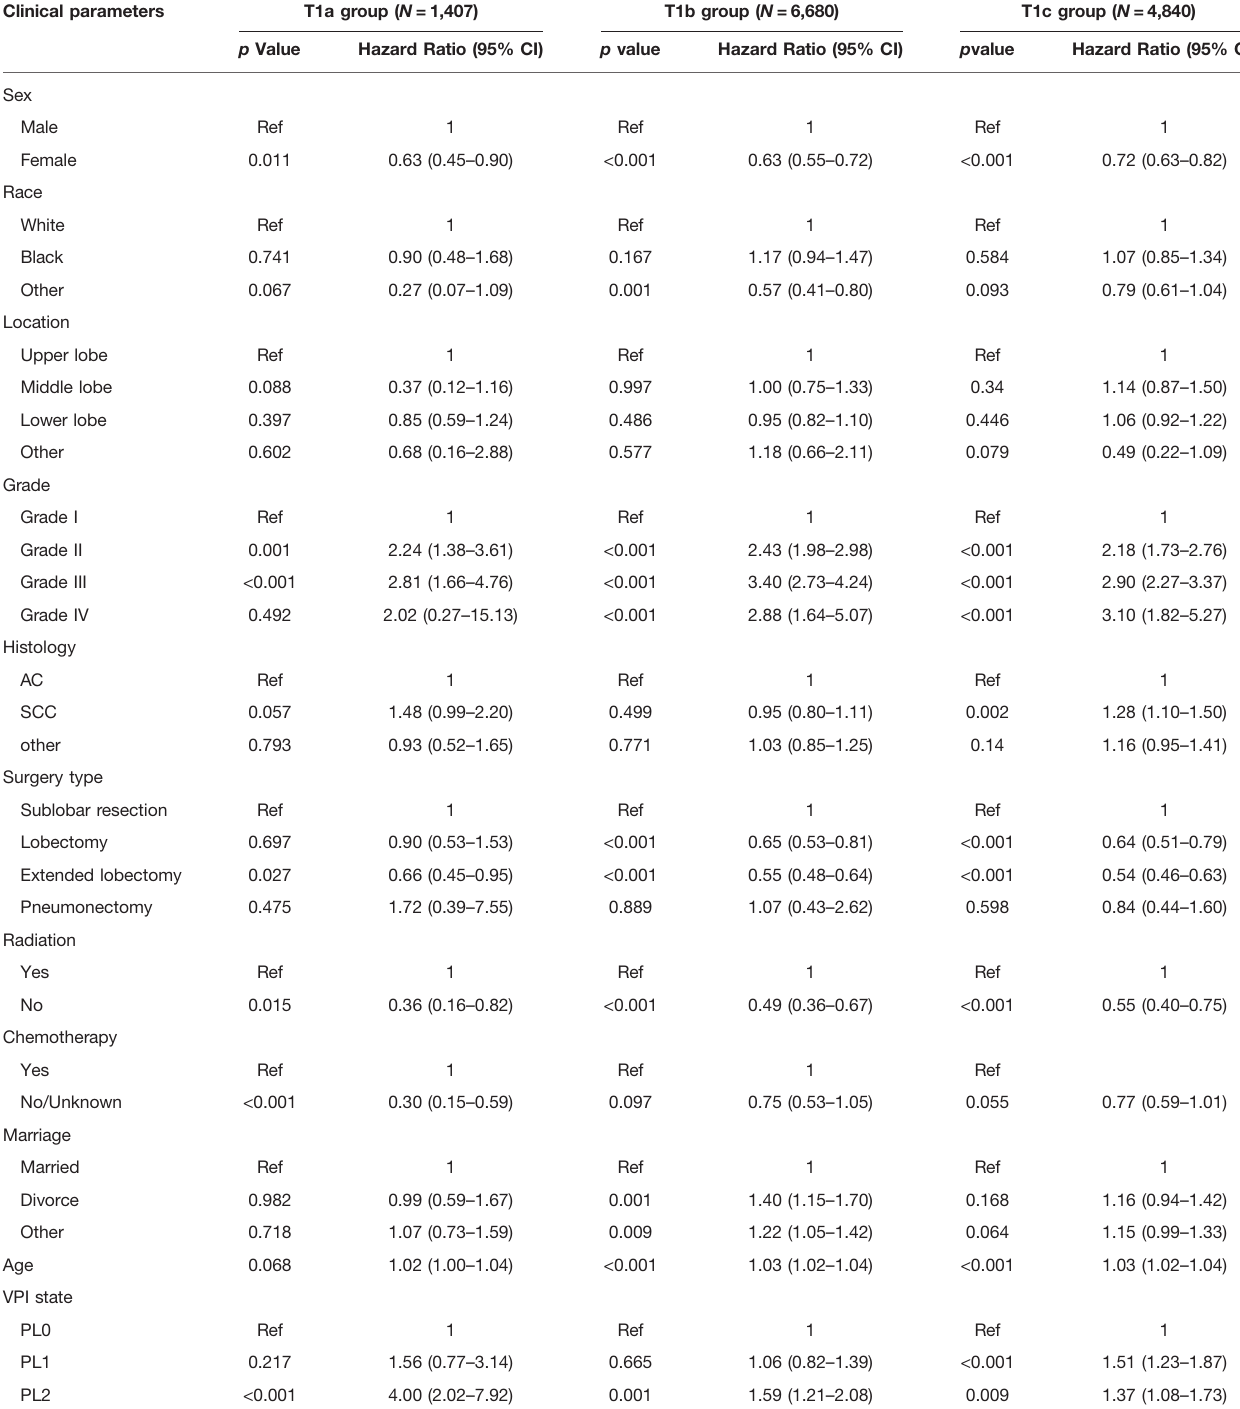
TABLE 3 | Multivariate COX regression of the prognostic factors of LCSS in patients without LN metastasis ( N =12,927). Clinical